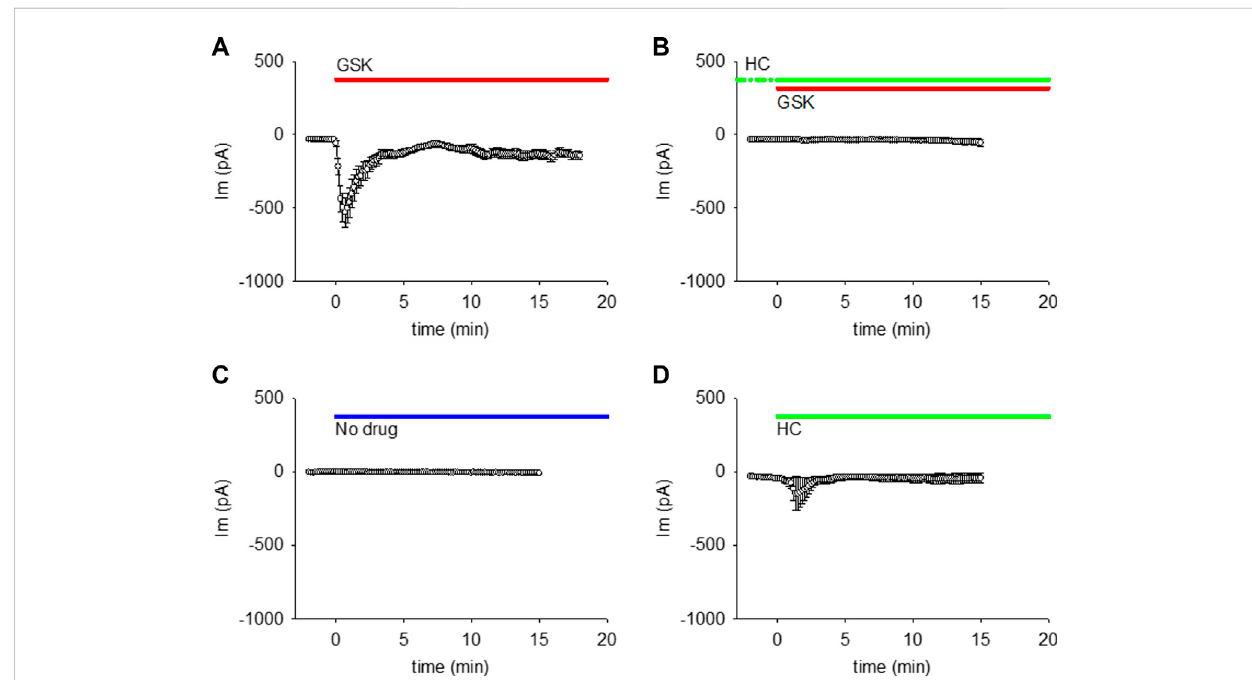
FIGURE 1 TRPV4 agonist GSK1016790A (GSK) increased the membrane conductance (gm) of lens epithelial cells, while TRPV4 antagonist HC067047 prevented this GSK-induced gm increase. (A, B) TRPV4 activation increased the WC Im at a holding potential of − 50 mV (A, n = 27), while TRPV4inhibitionpreventsthatImincrease(B,n=12). (C,D) WCImatholdingpotentialof − 50 mVdidnotincreasewithexternalsolutionwithoutdrug(C, n =7),whileHCalonecausedasmallincreaseinoneoutof fi vecells(D, n =5).Fortheseandallakin fi gures,thelinesontopofeachplotindicatethe application and continuous presence of the used